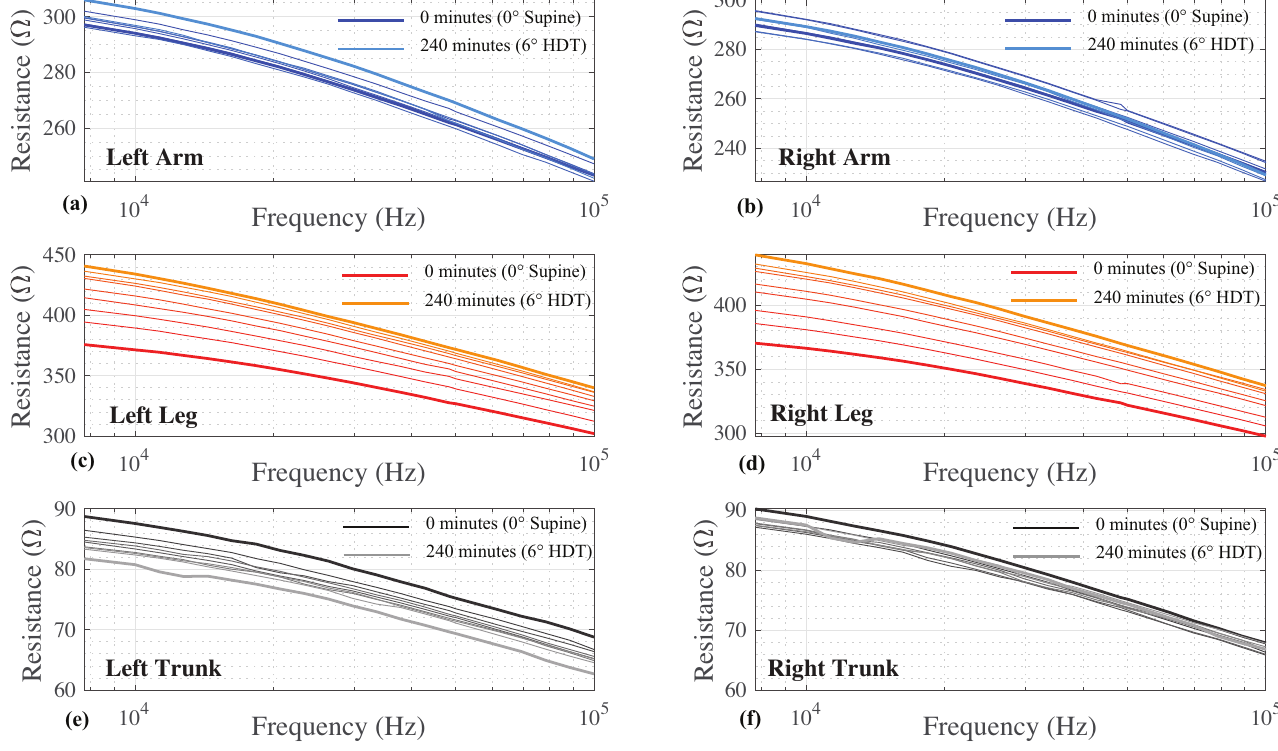
Figure 3. Segmental tissue resistance (from 7 to 100 kHz) of ( a ) left arm, ( b ) right arm, ( c ) left leg, ( d ) right leg, ( e ) left trunk, and ( f ) right trunk of a single study participant collected at 30 min intervals while the participant was in the HDT position. The darkest and lightest lines indicate the first and last measurements, respectively, through this protocol. Table 2. Median 10 kHz resistance of left and right legs, arms, and trunk segments of the study